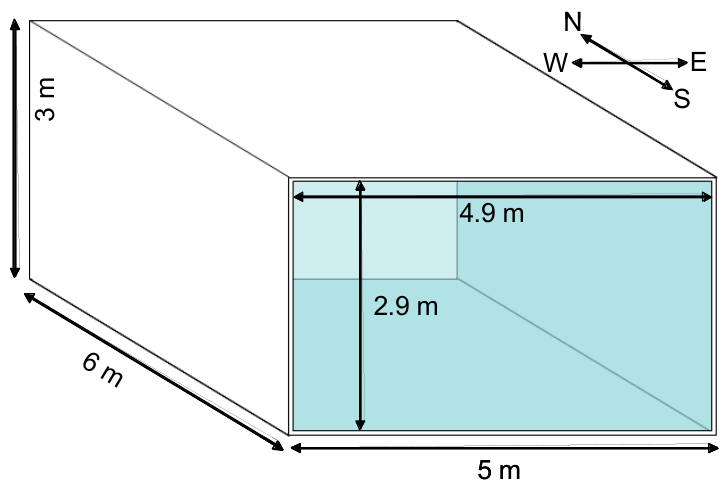
Figure 8. Schematic of room modeled in Energy PlusTM.